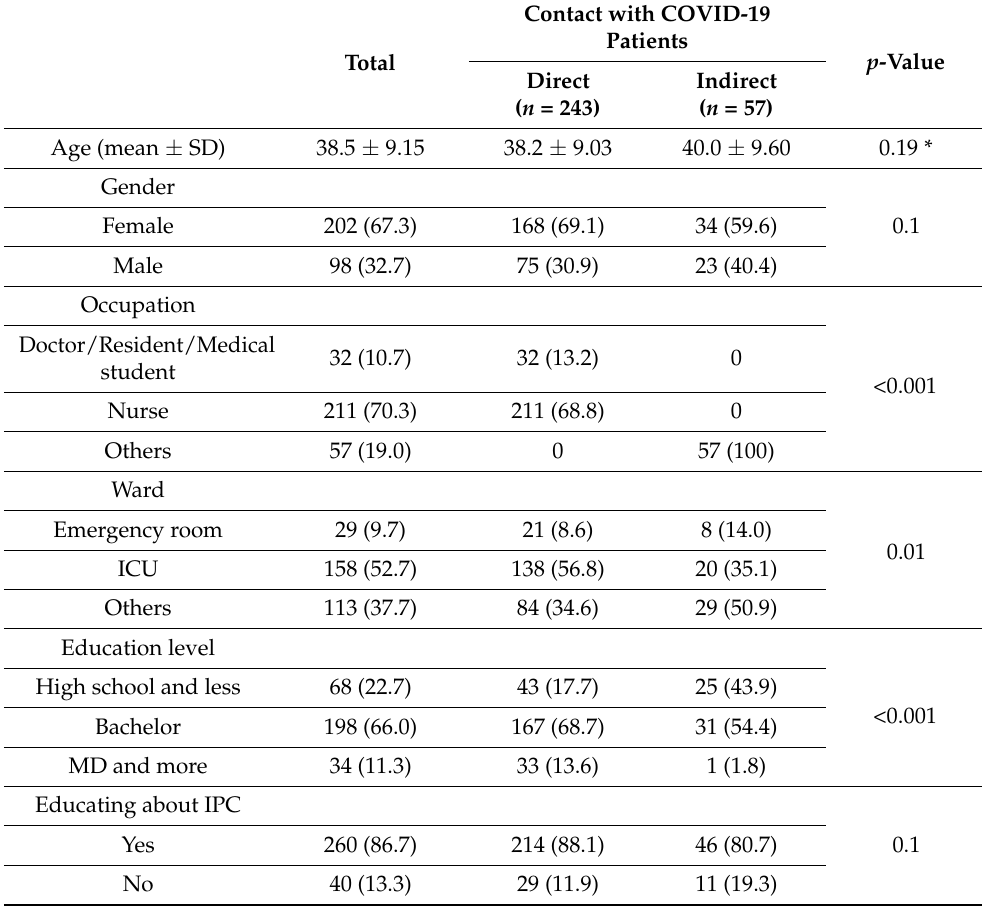
Table 1. Demographic and clinical characteristics of study population.